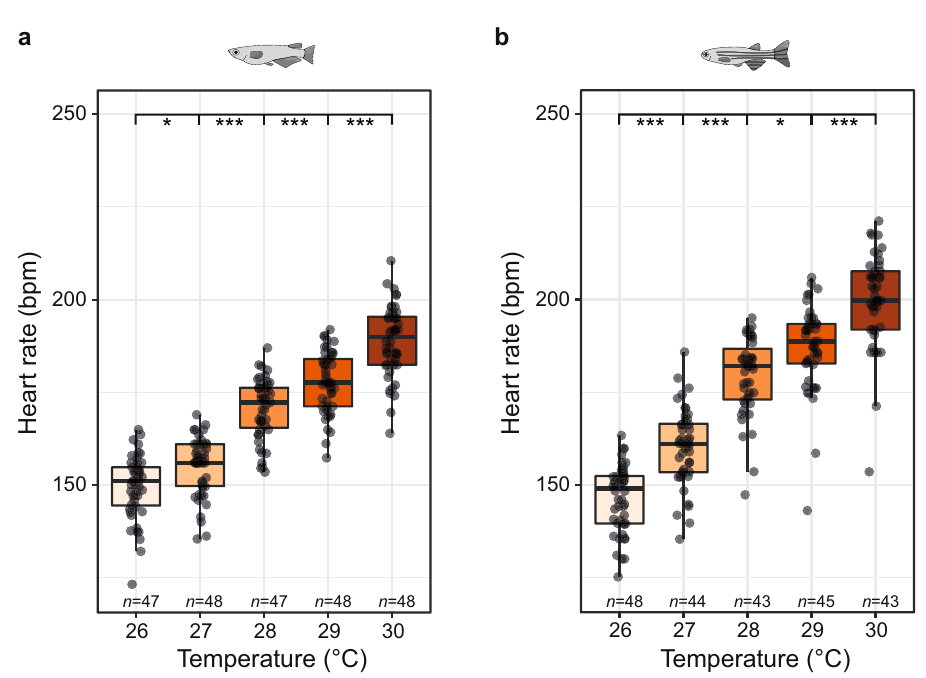
Figure 5. Temperature-dependent heart rate modulation. ( a,b ) Heart rate response to temperature gradients in medaka (100–102 hpf, n = 47–48 at each temperature in a ) and zebrafish (31–33 hpf, n = 43–48 at each temperature in b ) recorded at 13 fps. Significant differences between heart rates at each temperature were tested with one-way ANOVA and pairwise comparisons using Student’s t-test and are given with * P < 0.05, ** P < 0.01 and *** P < 0.001 (significant differences are indicated only for 1 °C-increments; P -values for all pairs of combinations in a,b are given in Supplementary Table S1 and S2, respectively); data is presented as box plots (median ± interquartile range) and overlaid scatter plots of heart rate